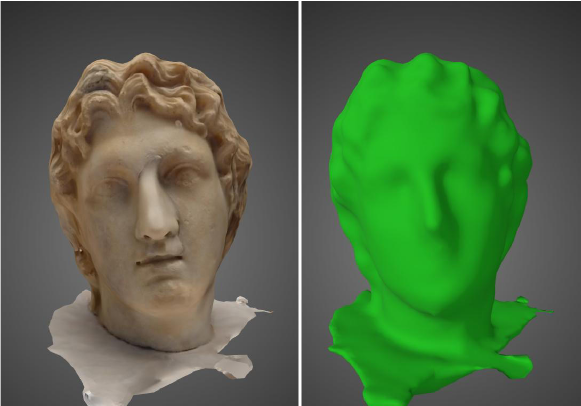
Figure 4. Head of Alexander the Great (marble); on the left, the textured head, on the right the 3D model without the